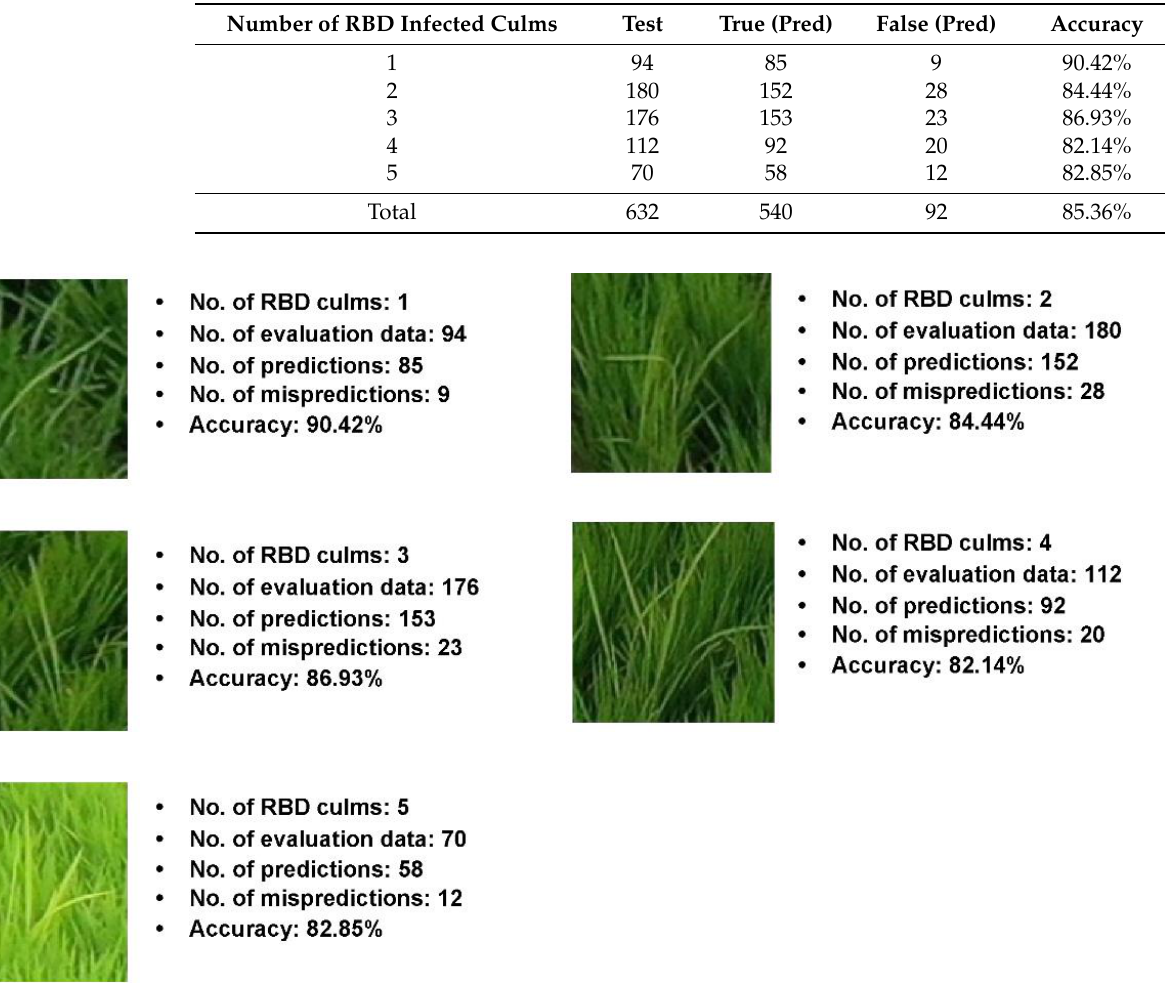
Figure 22. The prediction result of RBD based on reconstructed number of culms data.